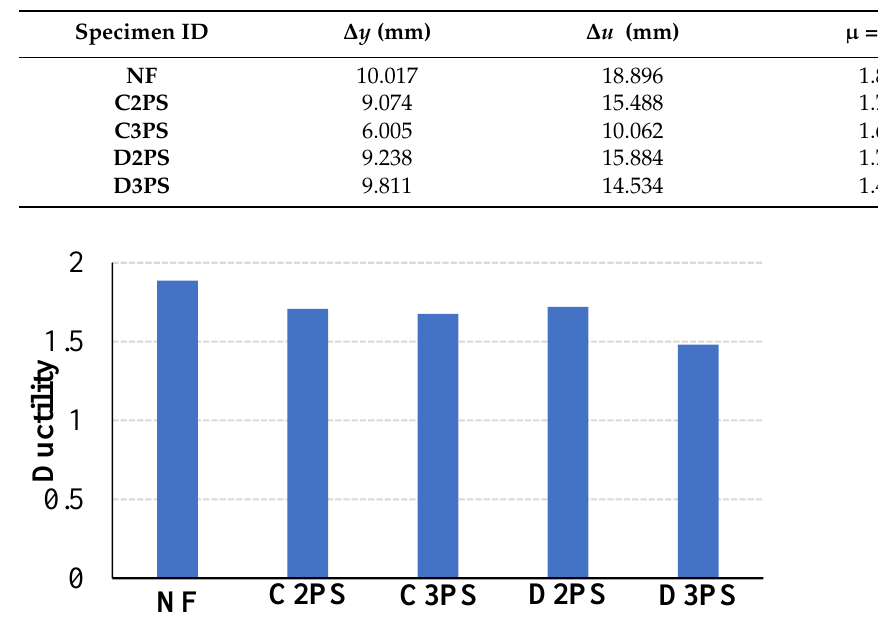
Figure 12. Ductility ratio for specimens.